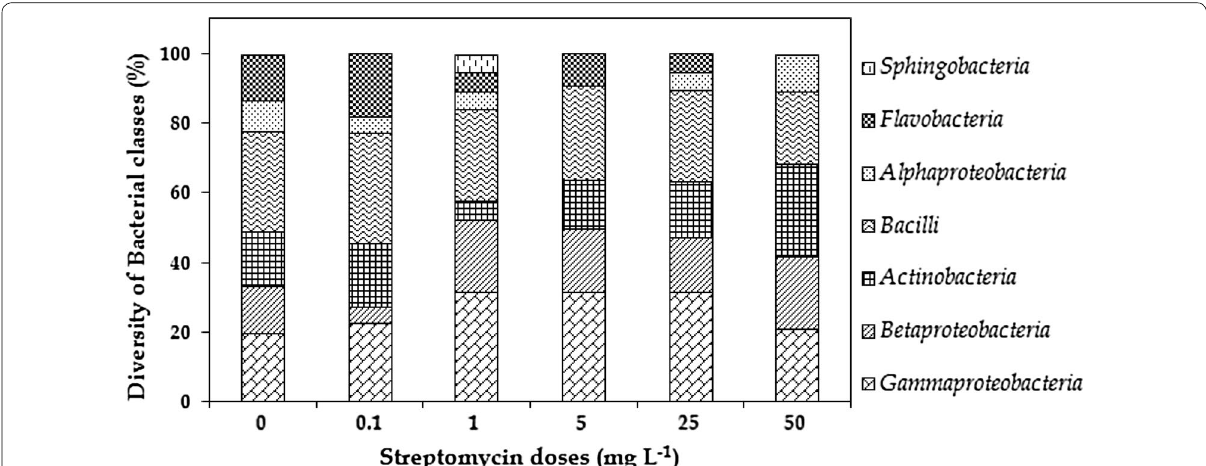
Fig. 2 Distribution of bacterial classes harvested from the long‑term wastewater reactor treated with stepwise‑increasing doses of streptomycin